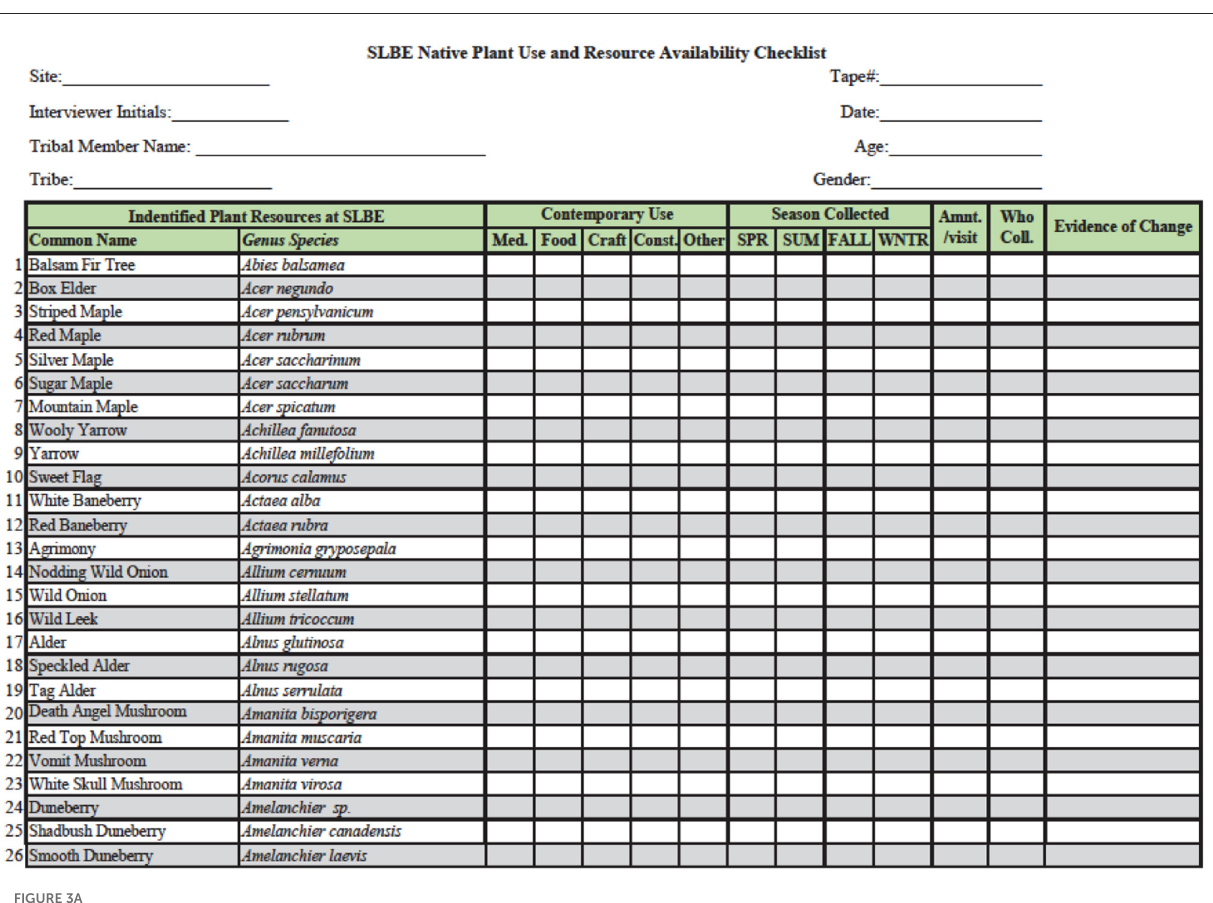
FIGURE3A Native plant use and resource availability checklist.